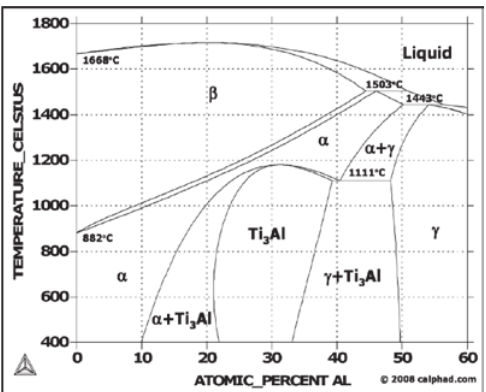
fig. 2. Phase diagram of the Ti-Al Complex aluminium and titanium nitride (AlTi) N, which is based on the crystal lattice of aluminium nitride, has good heat-resistance at temperatures around 800 ºC.